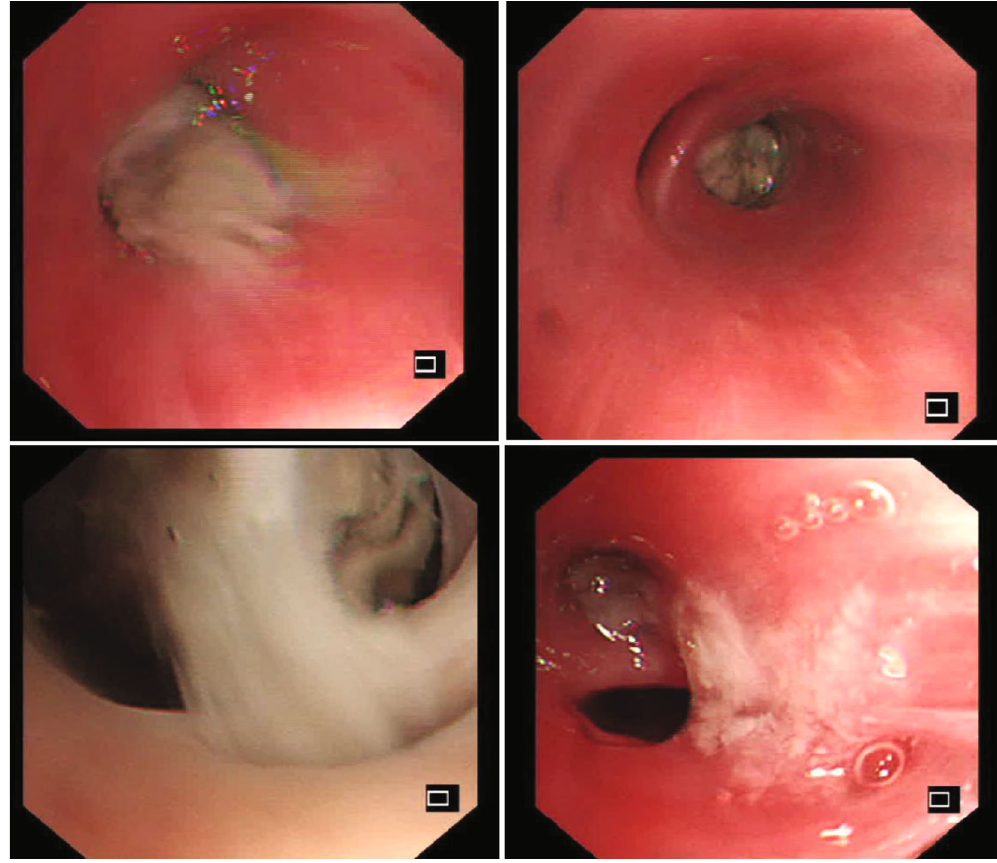
Figure 3: Flexible bronchoscopy revealed whitish, cheesy, and very viscid mucous plugging, which was challenging to be removed by